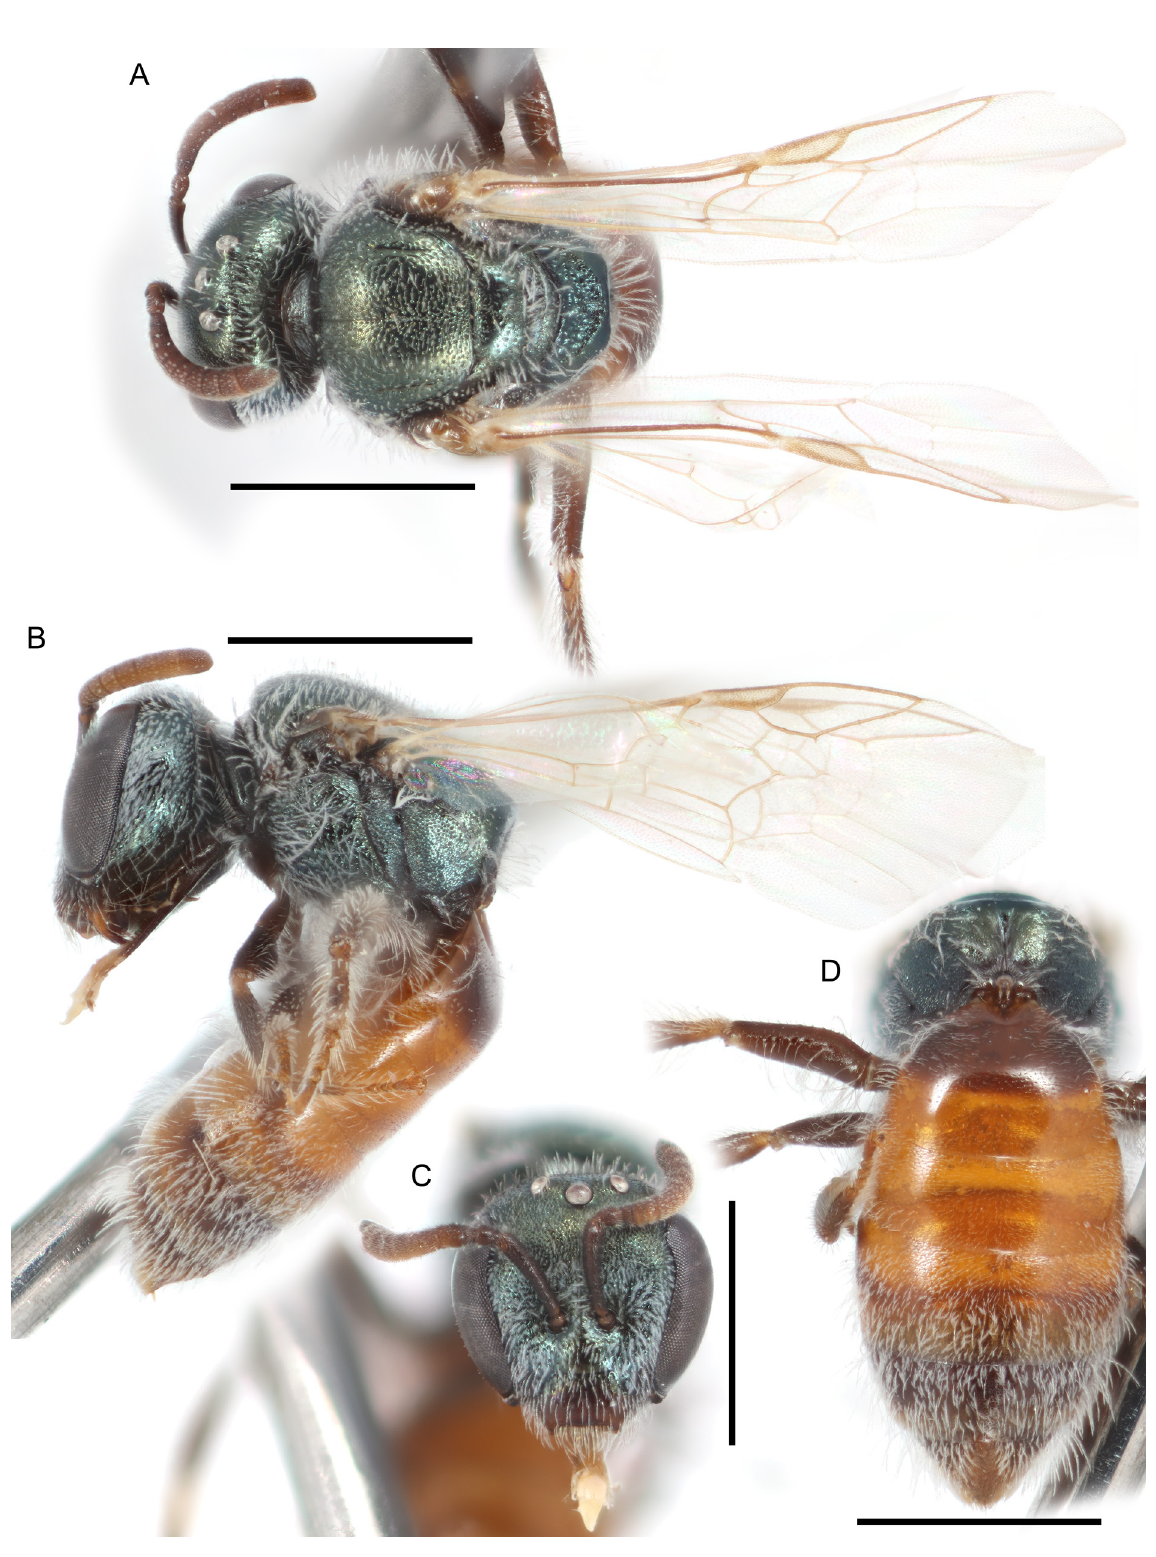
Fig. 78. Lasioglossum ( D. ) spivakae sp. nov., ♀. A . Dorsal habitus. B . Lateral habitus. C . Face. D . Propodeum and metasoma. Scale bars: 1